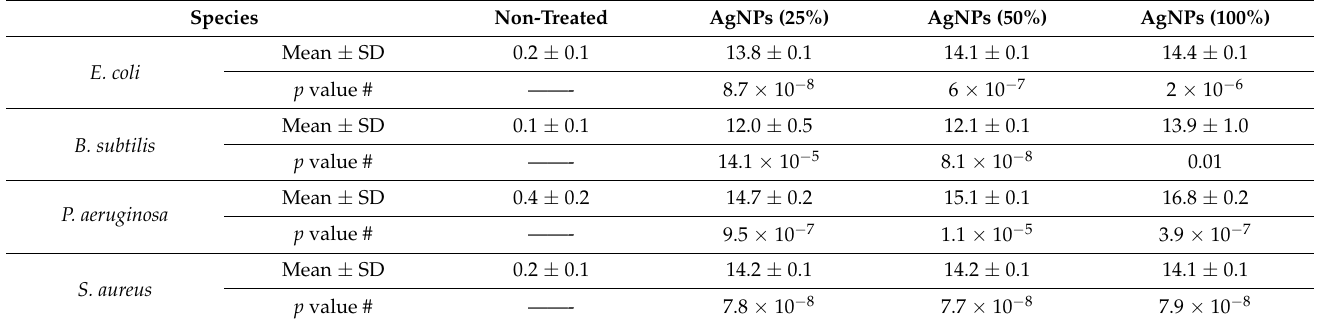
Table 5. Zone of inhibition for bacterial strains treated with AgNPs of the Palm leaves ethanolic extract.